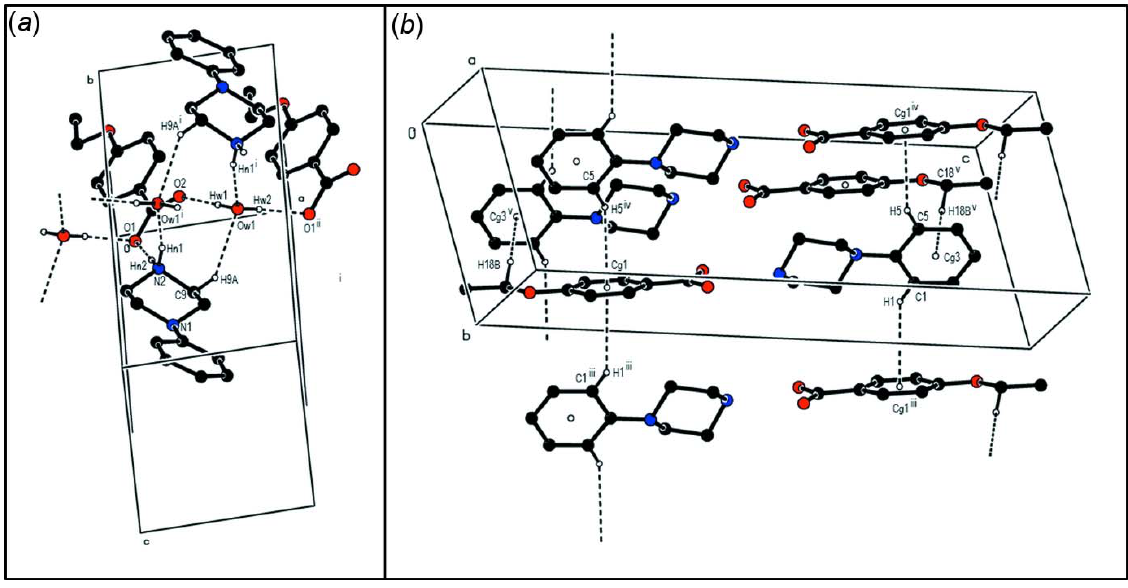
Figure 5 Parts of the crystal structure of compound ( I ) showing ( a ) the formation of a cyclic hydrogen-bonded R 4 H (cid:2)(cid:2)(cid:2) (cid:2) interactions parallel to [100]. Hydrogen bonds and C—H (cid:2)(cid:2)(cid:2) (cid:2) interactions are drawn as dashed lines.